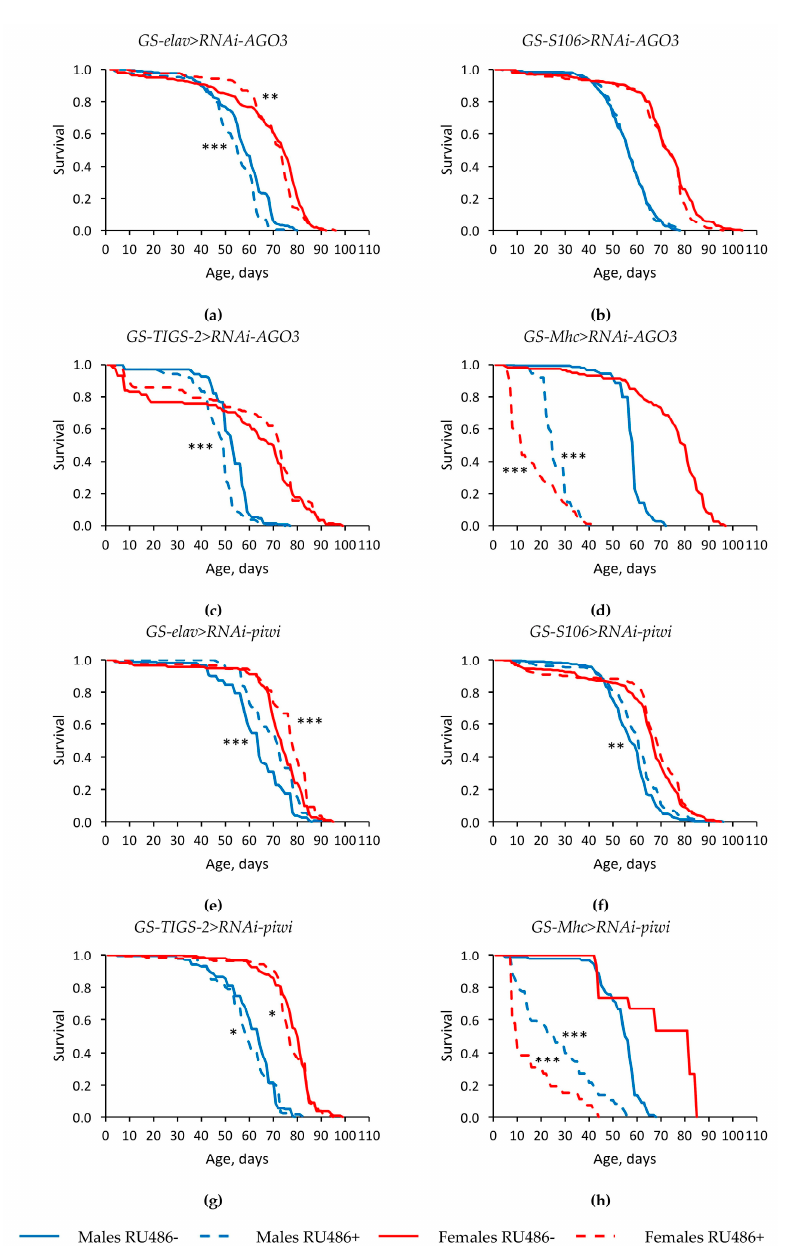
Figure 2. Influence of AGO3 ( a – d ) and piwi ( e – h ) knockdown in the nervous system ( a , e ) (two replicates combined), fat body ( b , f ) (two replicates combined), guts ( c , g ), muscles ( d , h ) on the survival of Drosophila melanogaster . Differences between survival curves of flies with PIWI genes’ knockdown (RU486+) and without knockdown (RU486-) are statistically significant with * p < 0.05, ** p < 0.01, *** p < 0.001 (Kolmogorov–Smirnov test).